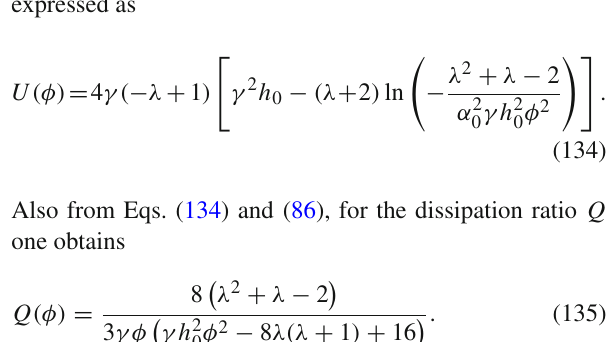
bluecontours.Intherightpanel,theresultsofPlanck2018areindicated by dark and light blue colors corresponding to68% and 95% confidence levels, respectively. In both figures the thick black lines refer to the the- oretical predictions, with the small, brown, and large, green, circles corresponding to the values of n s at the number of e-folds N = 55 and N = 65,